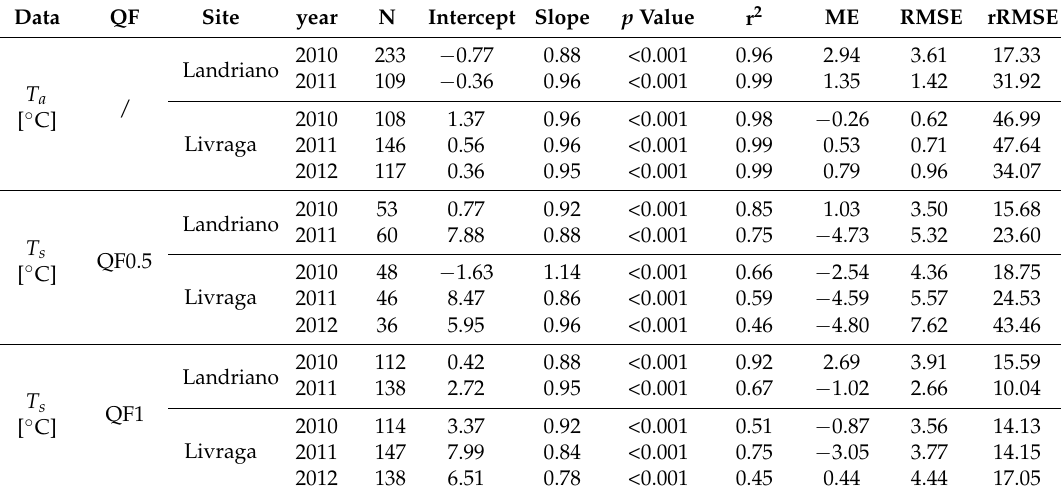
Table A1. Indices of agreement between estimated and measured T a and T s divided by sites and years; for surface temperature the accuracy metrics are provided for high (QF1) and low (QF0.5) quality levels. Data QF Site year N Intercept Slope p Value r 2 ME RMSE rRMSE